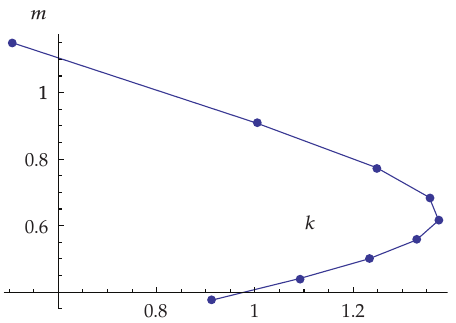
Figure 2: The motion of physical capital and real